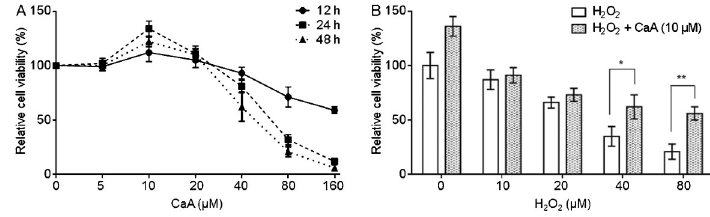
Figure 1. Caffeic acid (CaA) attenuated the H 2 O 2 -induced inhibition of L-02 cell viability. A , L-02 cells were treated with 0, 5, 10, 20, 40, 80, or 160 m M CaA for 12, 24, or 48 h. B , After pretreatment of L-02 cells with 0 or 10 m M CaA for 24 h, they were exposed to 0, 10, 20, 40, or 80 m M H 2 O 2 for 24 h. Cell viability was measured by cell counting and comparison with control cells treated with culture medium only. *P , 0.05 and